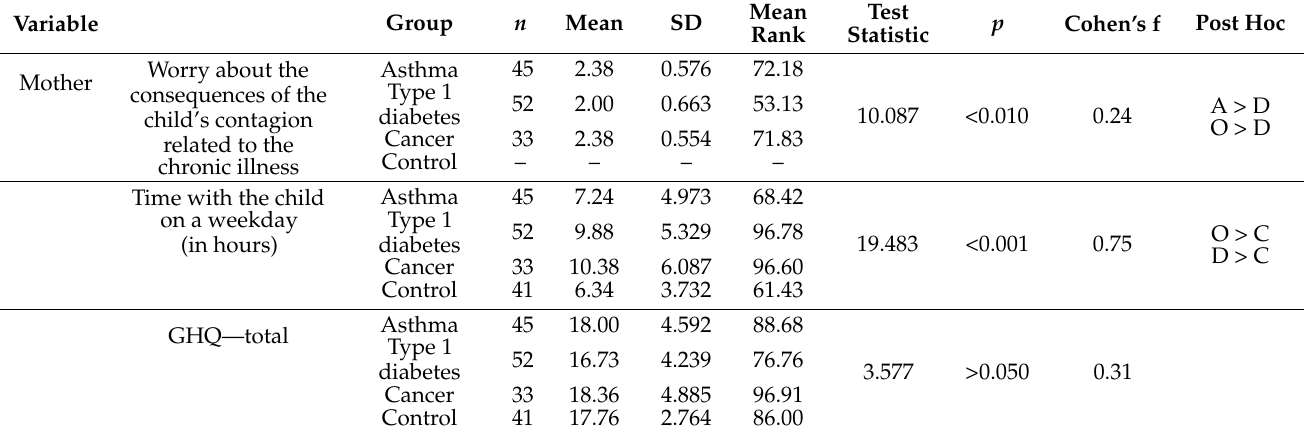
Table 3. Kruskal–Wallis test for the clinical and control samples’ mothers. Cohen’s f values: